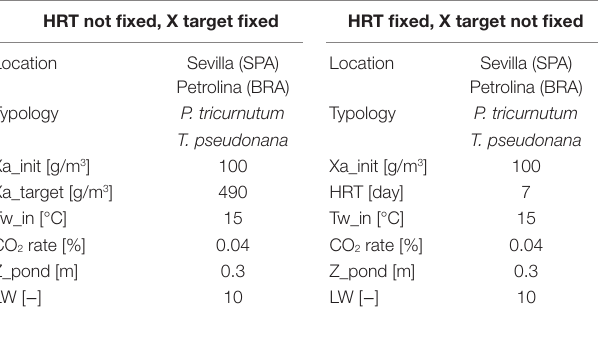
TaBle 4 | input data for open pond